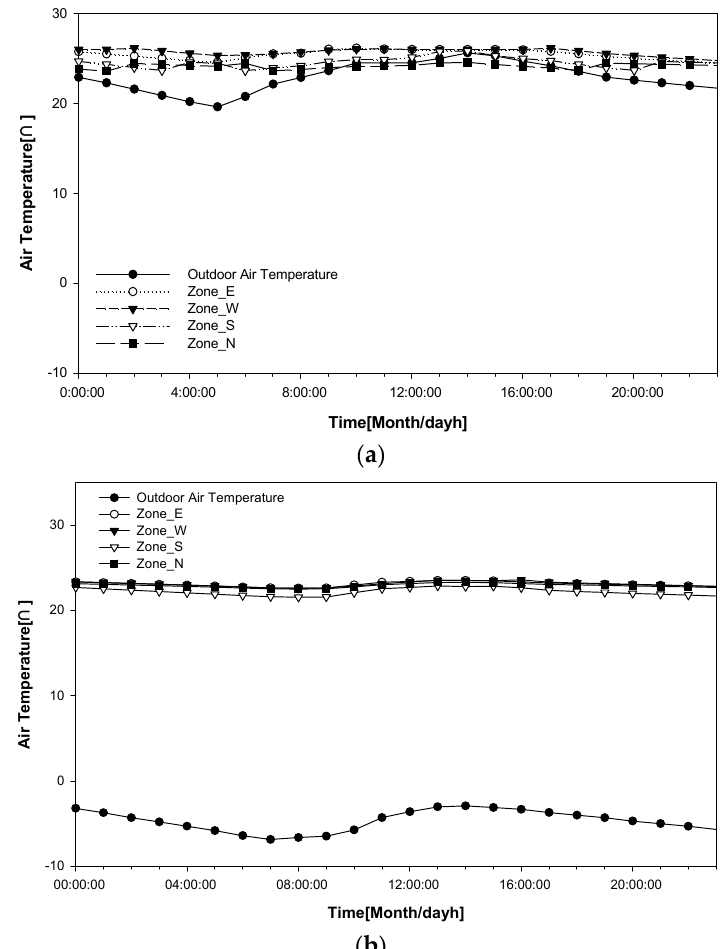
Figure 13. Analysis of Room Temperature According to the Proposed Control Method: ( a ) Indoor air